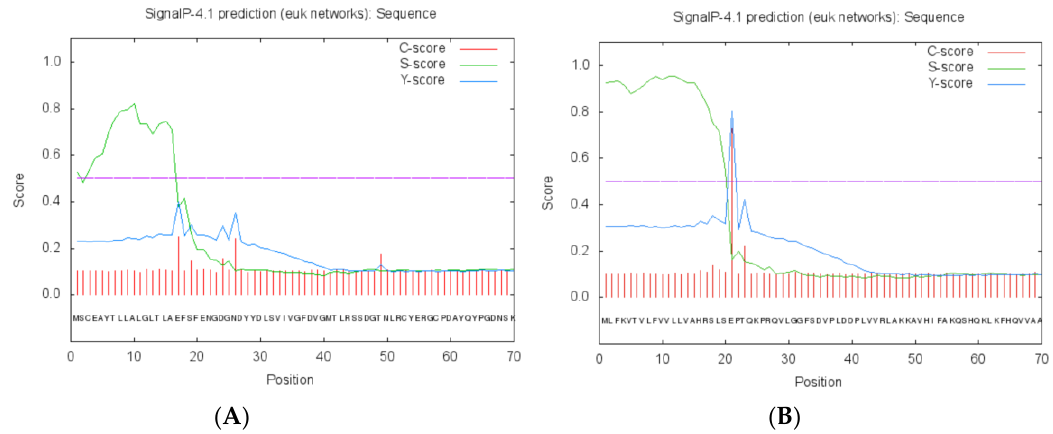
Figure 4. Signal peptide prediction analysis of ( A ) Bx-TLP-2 and ( B ) Bx-CPI.